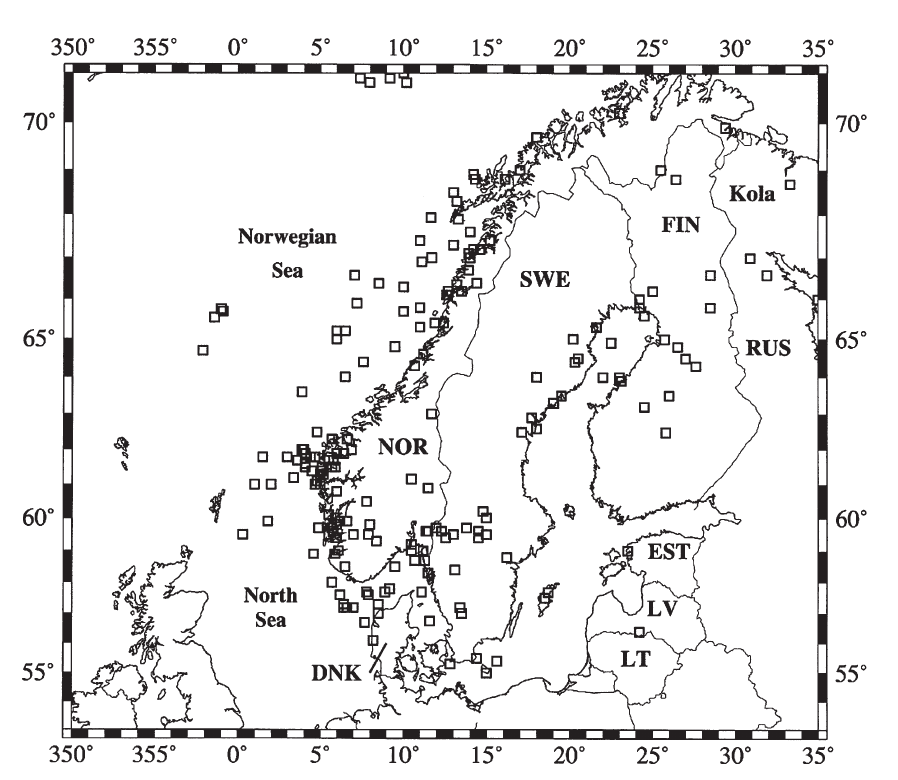
Fig. 1a. Region addressed in the present study. Letters denote present-day Denmark, Estonia, Finland, Latvia (LV), Lithuania (LT), Norway, Russia and Sweden. Squares show epicentres for earthquakes of magnitude 4 and above oc- curring between 1375 and 1964 as given in the FENCAT catalogue (Ahjos and Uski, 1992) and its updated version (http://www.seismo.helsinki.fi). The reported event magnitudes are of the ML type but stem from a variety of sources. Some events are located in offshore areas reflecting mechanical seismograph installations up to the